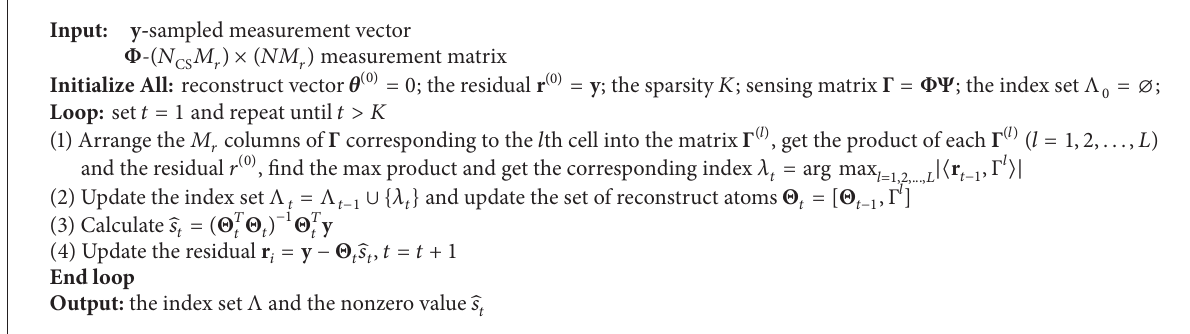
Algorithm 1: The procedure of JOMP algorithm.